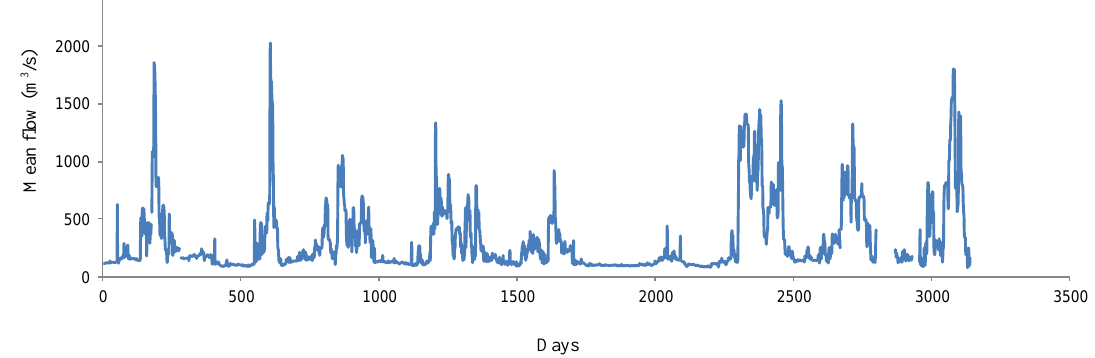
Figure 4. Hydrograph of the lower Ebro River highlighting the main floods for the period 2006–2015. Source: modified from CSTE [19].